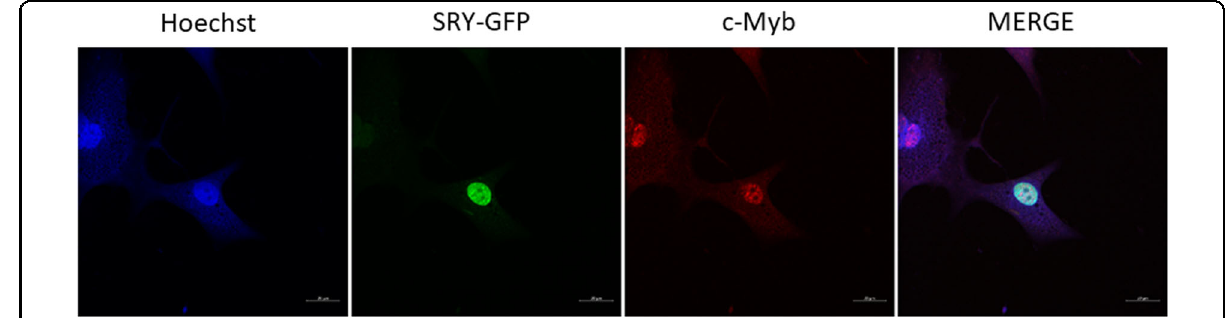
Fig. 4 Localization of SRY and cMyb in primary osteoblast cells of male origin. Localization of SRY-GFP fusion protein in male primary osteoblasts. Color legend for merged image: blue, Hoechst 33342 nuclear stain; green, SRY-GFP fusion protein; red, antibody targeting endogenous cMyb. POB primary osteoblasts; GFP green fl uorescent protein. Scale bar: 10 μ